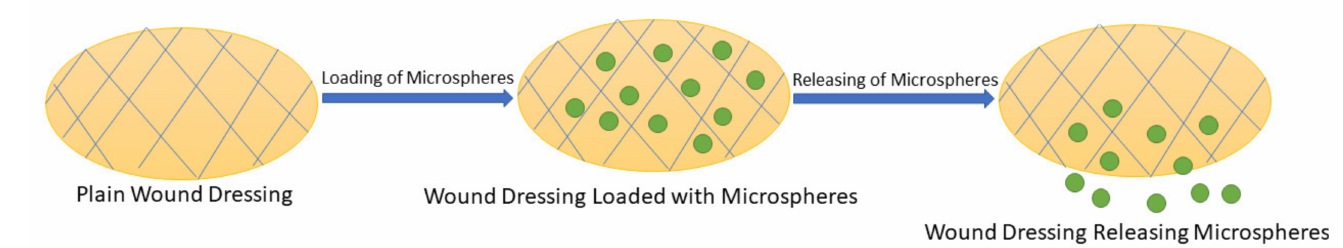
Figure 9. Schematic Diagram of Wound Dressing loaded with